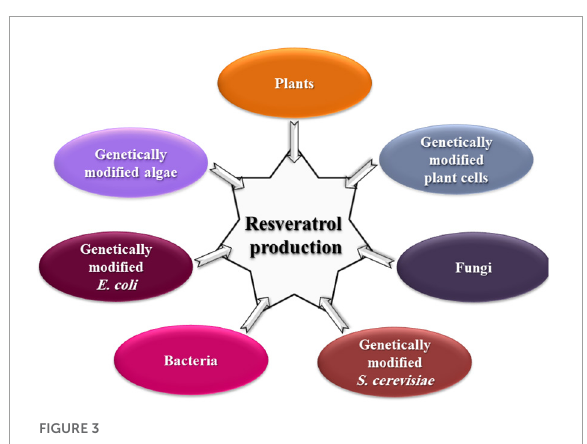
FIGURE3 Different natural sources for resveratrol